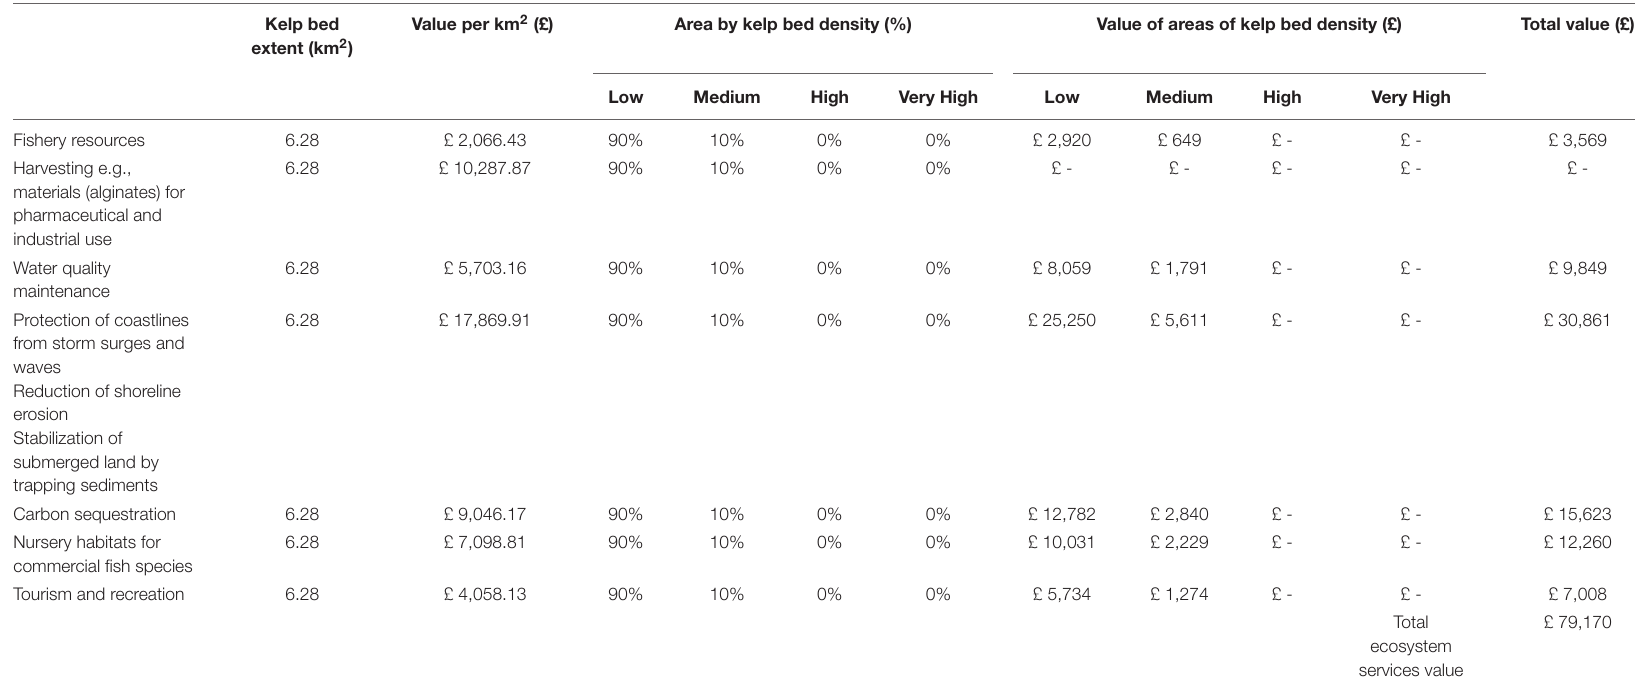
TABLE 5 | Calculations of current ecosystem service benefits of kelp used in the